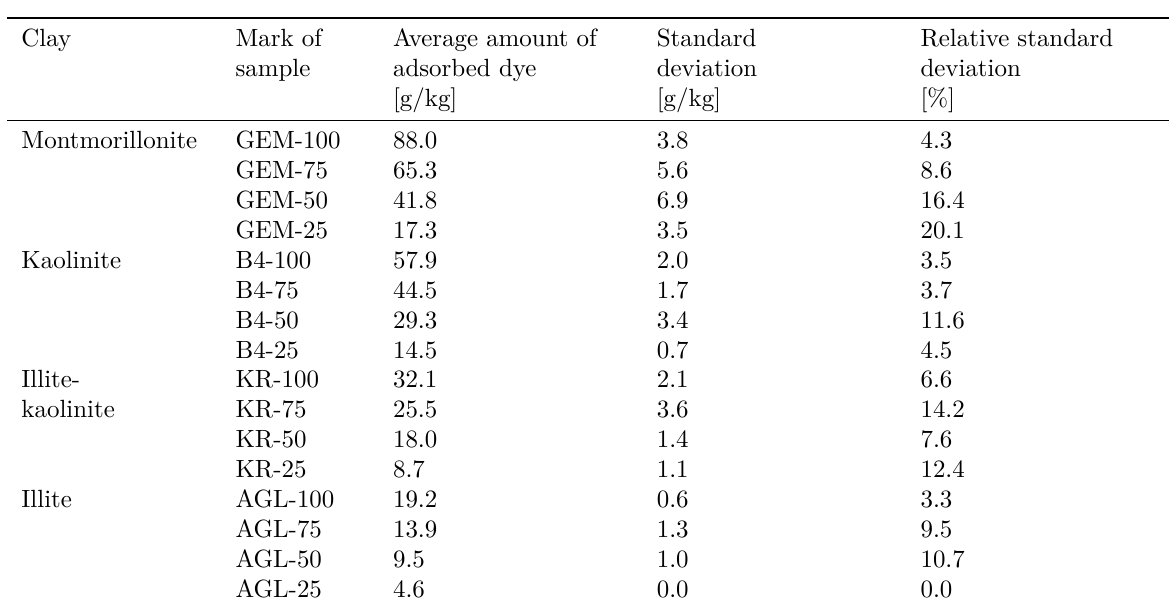
Table 3. Results obtained by methylene blue test.